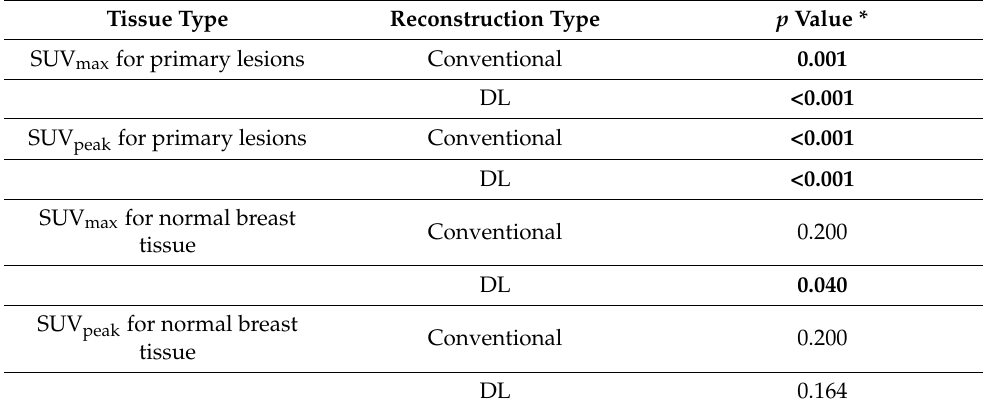
Table 3. Kolmogorov–Smirnov test for standardized uptake values (SUVs).